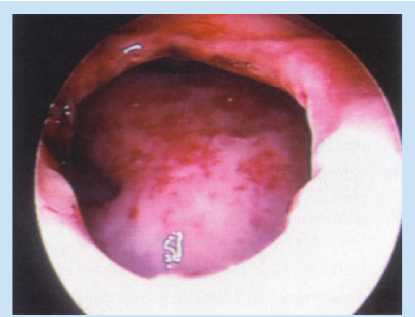
Fig 4b. Endoscopic nasal view showing multiple small red telangiectasias seen through a perfora- tion of the nasal septum, a complication of repeat- ed surgical attempts at managing the recurrent epistaxis in this